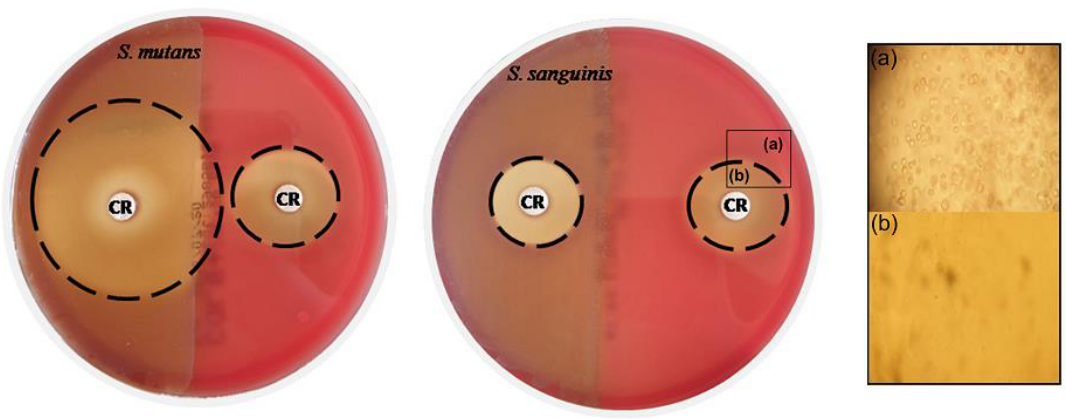
Figure 6. Hemolytic effect of CAR on blood agar plates. The left halves of both plates were inoculated with S. mutans ( left ) and S. sanguinis ( right ). ( a ) Healthy and ( b ) Hemolyzed red blood cells observed by optical microscopy. Disks contained CAR at 95.6 mg/mL.